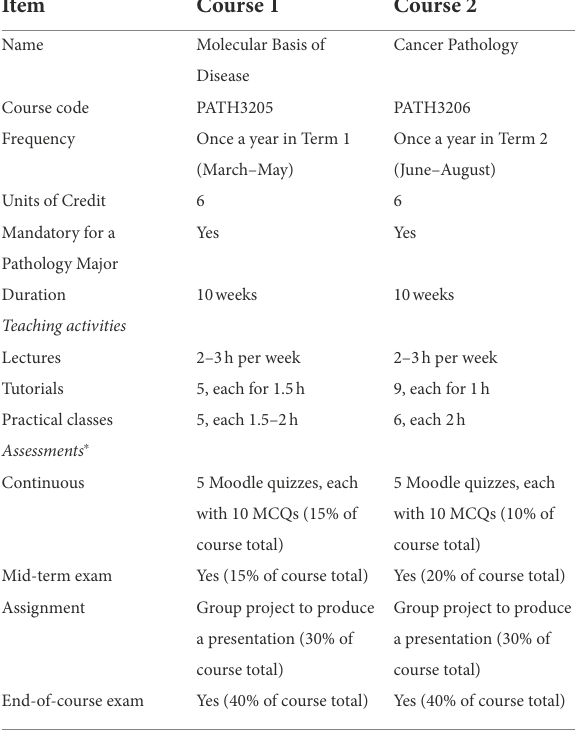
TABLE 1 Similarities and differences between the two Pathology courses evaluated in this